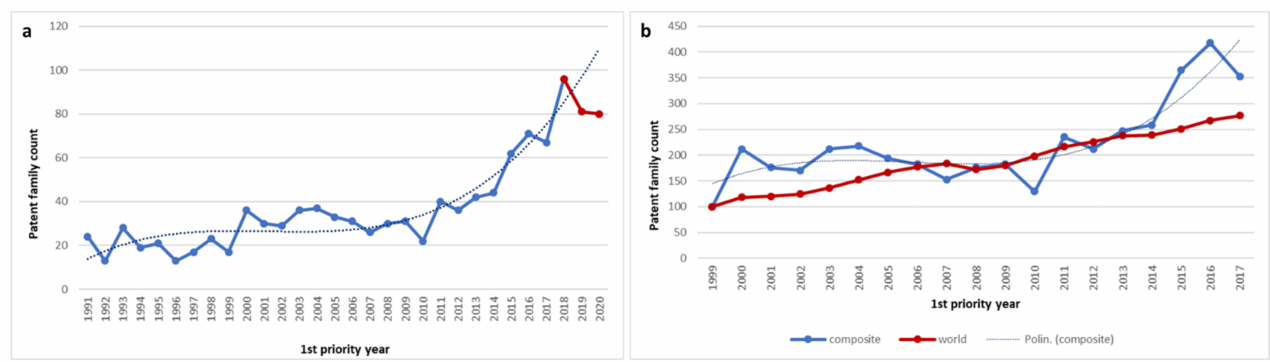
Figure 1. ( a ) Historical trend of patenting activity by first priority year (blue line represents the trend of patents filed between 1991-2018, red line represents the trend of patents filed during the non-representative two-year period 2019–2020, and dotted line represents the overall trendline); ( b ) benchmark between composite recycling processes patent activity and worldwide patent